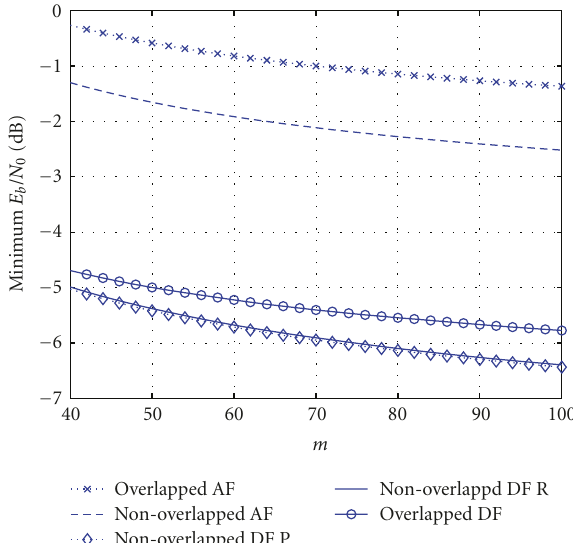
Figure 16: E b , U /N 0 versus m for di ff erent transmission scheme